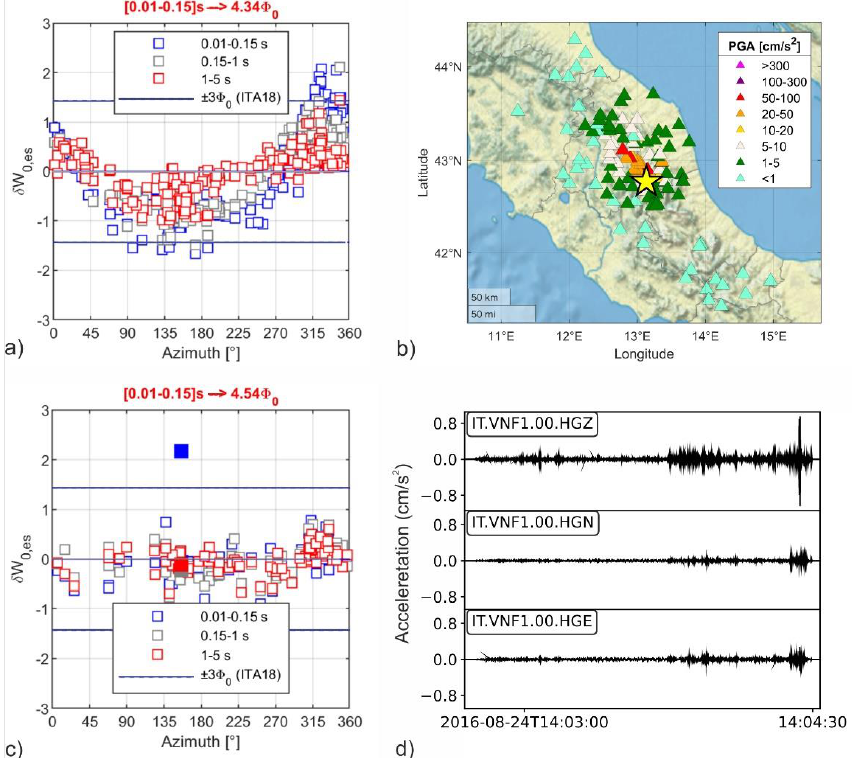
Figure 8. ( a ) example of peculiar δW 𝑜,𝑒𝑠 residuals due to rupture directivity of the event EMSC- 20160903_0000009, and ( b ) spatial distribution of the corresponding PGA values. ( c ) Example of peculiar δW 𝑜,𝑒𝑠 residual due to a bad quality recording of the event EMSC-20160824_0000192 (filled squares highlight the anomalous values); and ( d ) accelerometric time history of the anomalous record highlighted in panel ( c ).